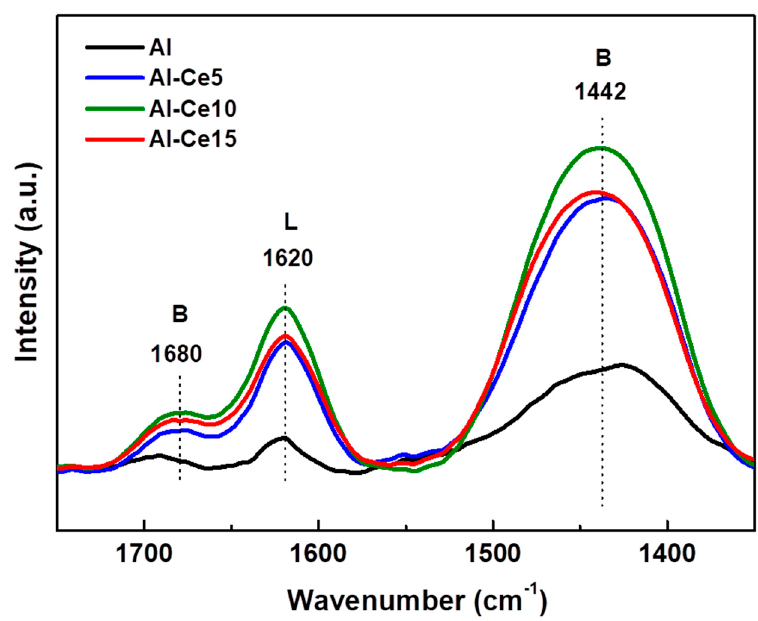
Figure 4. DRIFTS ‐ NH 3 spectra for pure supports. Figure 4. DRIFTS-NH 3 spectra for pure supports.